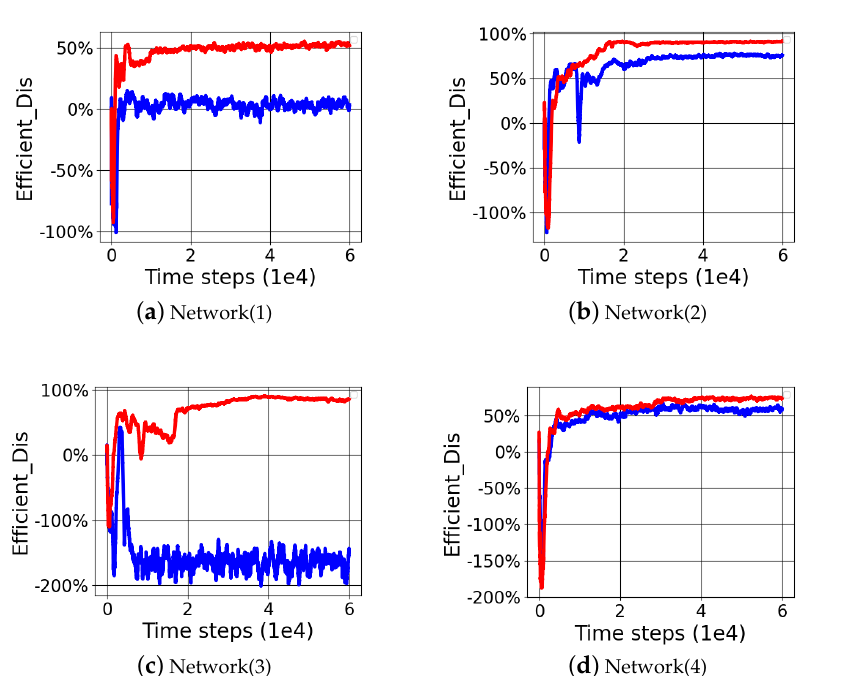
Figure 9. Under the reward function(3), the efficient distances between RTD3 (red) and TD3 (blue) for four times of randomly initialized network node parameters under the same initial network node conditions as shown above in ( a – d